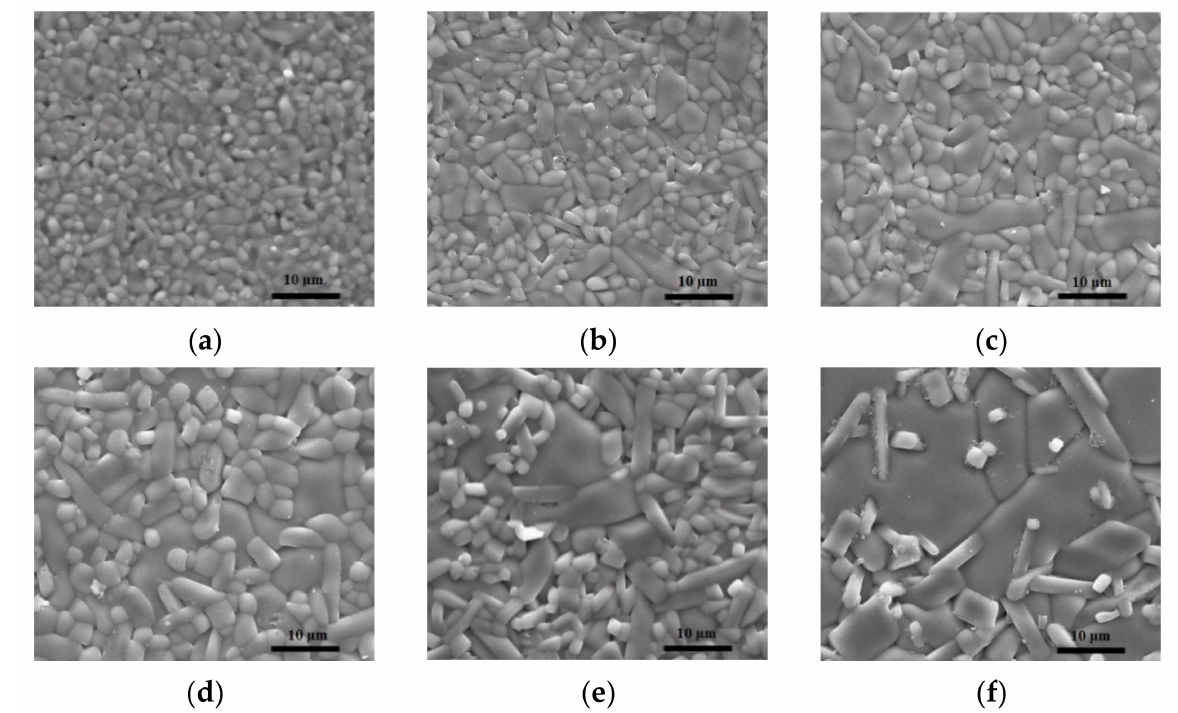
Figure 3. SEM photographs of (Mg 0.6 Zn 0.4 ) 0.95 Ni 0.05 TiO 3 sintered at temperature range ( a ) 1125, ( b ) 1150, ( c ) 1175, ( d ) 1200, ( e ) 1225 and ( f ) 1250 ◦ C for 4 h.